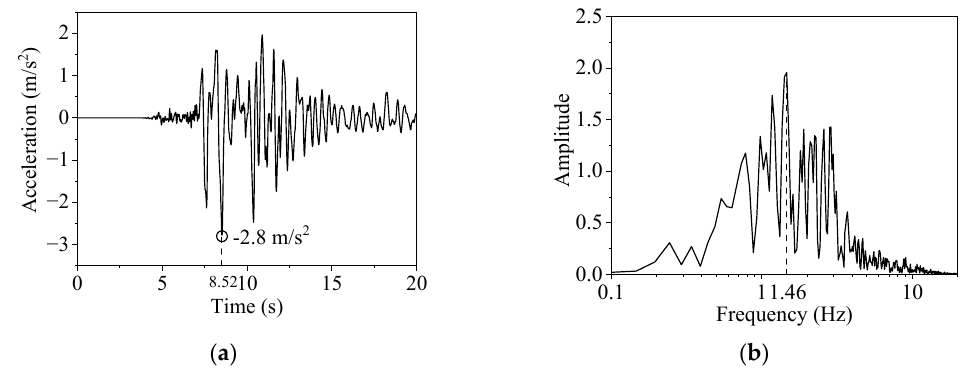
Figure 9. The Kobe wave: ( a ) time history; ( b ) Fourier spectrum. The incident direction of the seismic wave is parallel to the x – z plane and forms an angle α of 0° (vertical incidence), 15°, and 30° with the y – z plane. According to the direc- tion of the axes in Figure 8, the x- , y- , and z- axes refer to the transverse, longitudinal, and vertical directions of the tunnel, respectively.